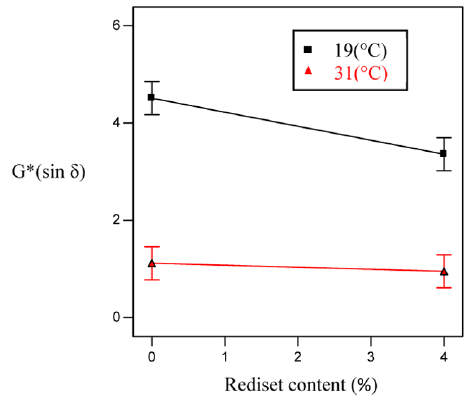
Fig. 10. Interaction effect of Rediset with temperature on the values of G*(sin δ) for PG64